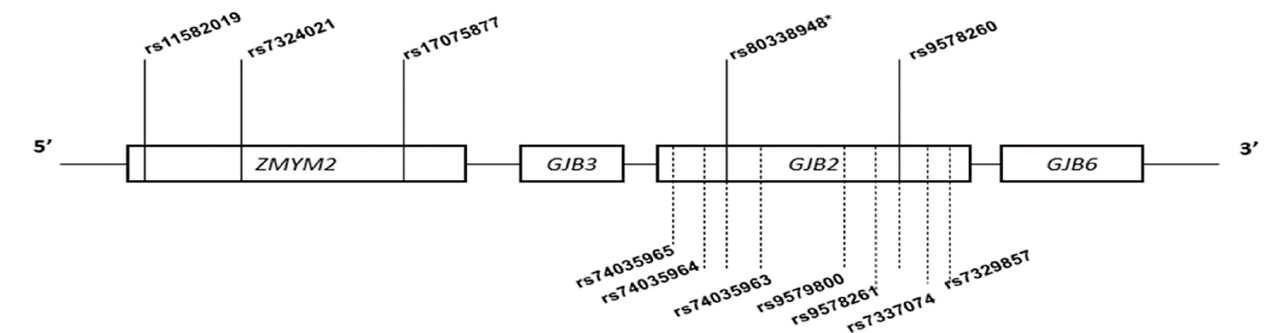
Figure 1. Schematic illustration of the five ancestral informative markers (AIMs) on the chromosome 13q12 locus (2-Mb region around the disease mutation) used for the age estimation and haplotype analysis in Ghanaian populations. Tagged SNVs in linkage disequilibrium were identified within a 128.445-kb region spanning the GJB2 : c.427C>T (Arg.R143Trp) locus. One marker in GJB2 : c.-22-12C>G and three markers in the zinc finger MYM-type containing 2 gene ( ZMYM2 ): c.3345A>G, c.3037+27T>G, and c.2857A>G, respectively. Unimputed markers (5) are shown above, and imputed markers (7) are shown below, represented by dotted lines. * = disease allele.